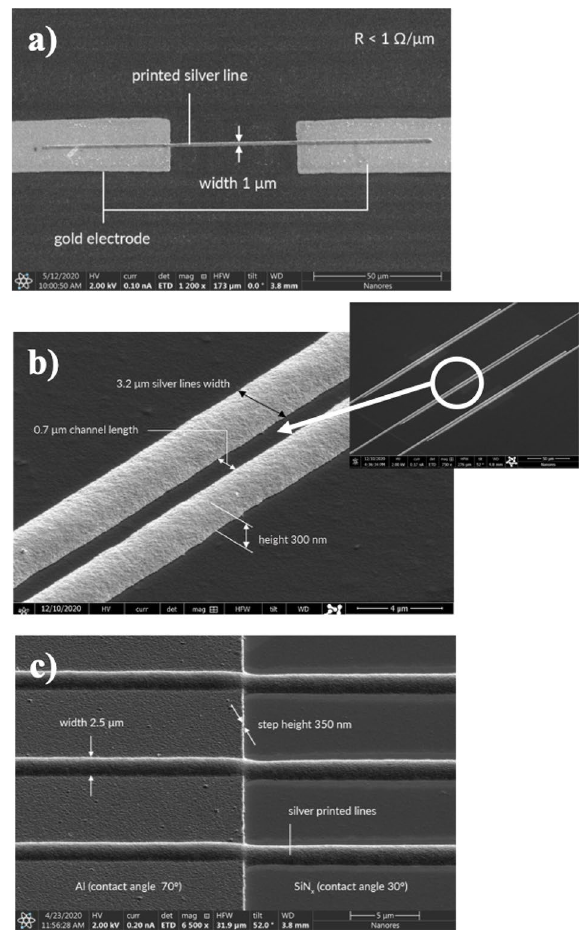
Figure 4. ( a ) Silver line with the width of 1 µm printed between two gold electrodes on glass. The electrical resistance of the line is below 1 Ω/µm; ( b ) silver lines with the width of 3 µm printed on a PEN foil. The line width is 3.2 µm and the interline distance is 0.7 µm. Note that the interline distance is kept constant and the printed lines are clearly separated. Distant view of the sample is shown in the inset; ( c ) hybrid substrates composed of materials characterized by different wetting properties: aluminum (Al) layer deposited on a PECVD silicon nitride (SiN x ) with a vertical step of 0.35